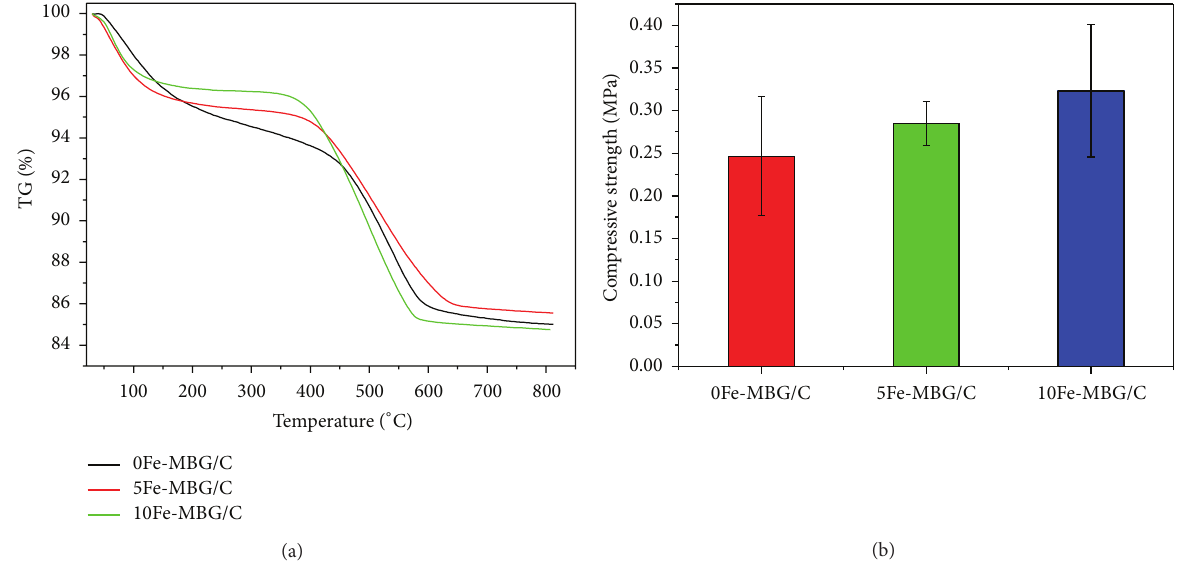
Figure 6: TG curves (a) and mechanical strength (b) of the Fe-MBG/C composite scaffolds with different Fe content.